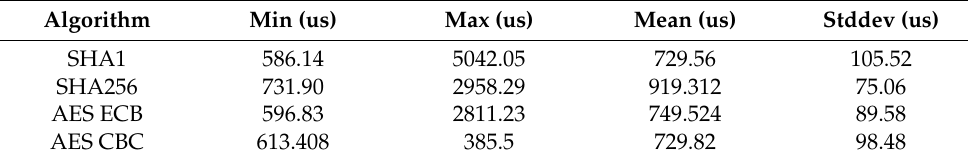
Table 3. SHA1, SHA256, AES ECB, AES CBC Execution